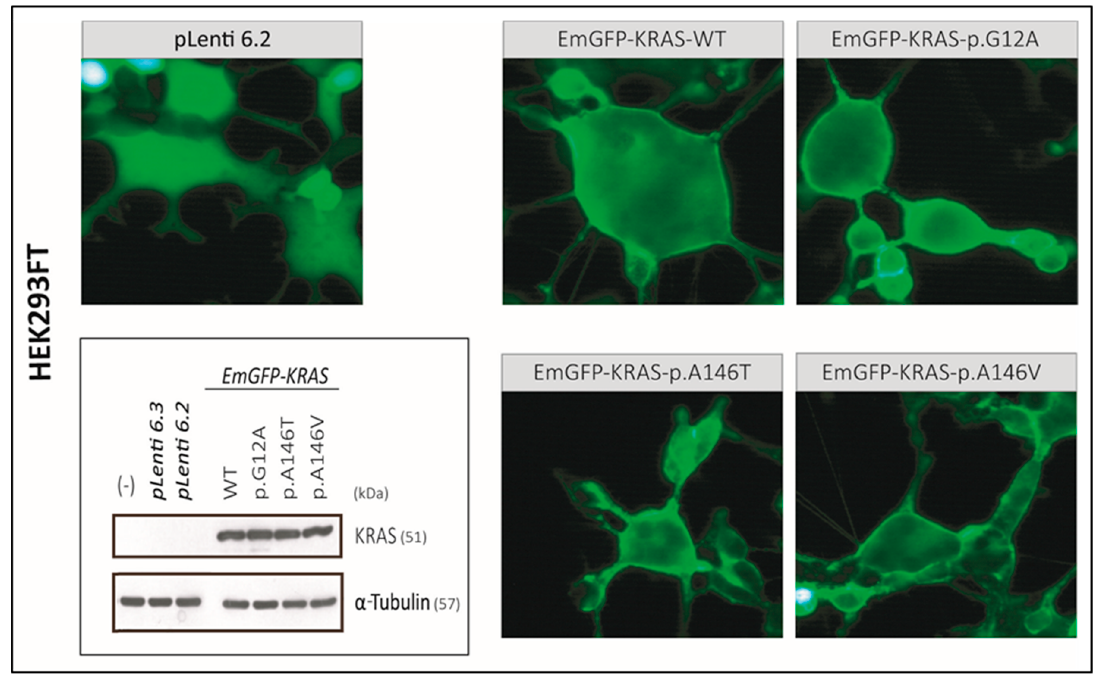
Figure 3. pLenti6.3 EmGFP-KRAS WT/p.G12A/p.A146T/p.A146V expression in HEK293 cells as demonstrated by Western blot and fluorescence microscopy analysis. All KRAS-constructs are predominantly localized to the cell membrane of HEK293 cells compared to the pLenti6.2-EmGFP control 24 h after transfection. Fluorescence microscopy analysis was performed at 400× magnification. The corresponding original Western blots are shown in Figure S2. The raw intensities and the intensity ratios for each band are listed in Table S2.